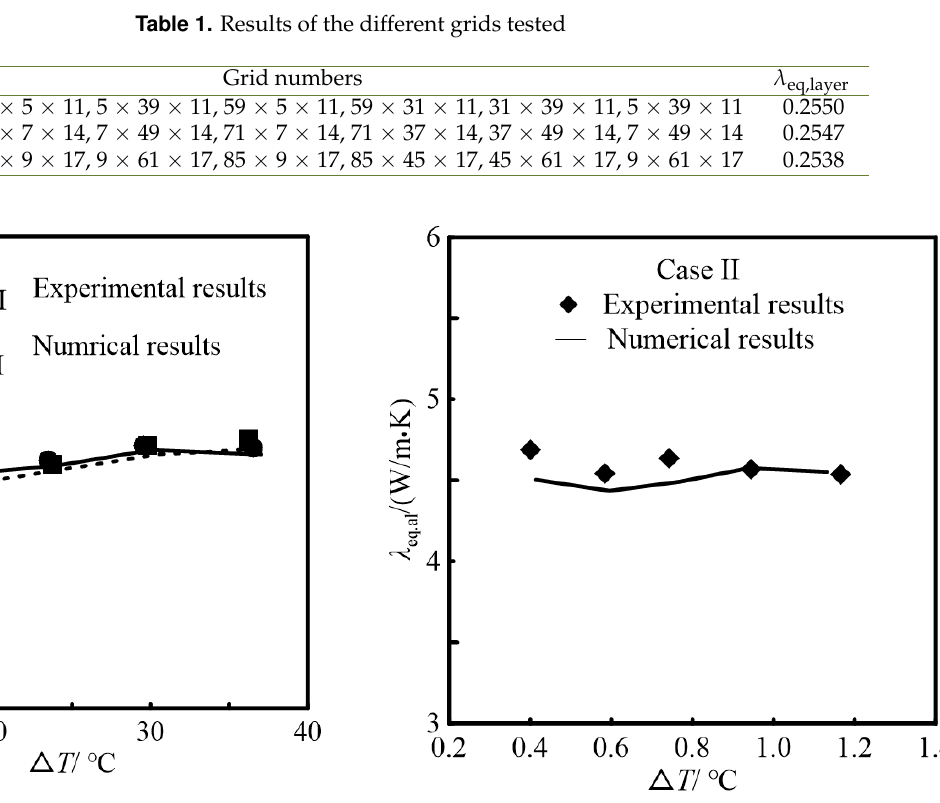
Fig. 5. The equivalent thermal conductivity of the test wall.